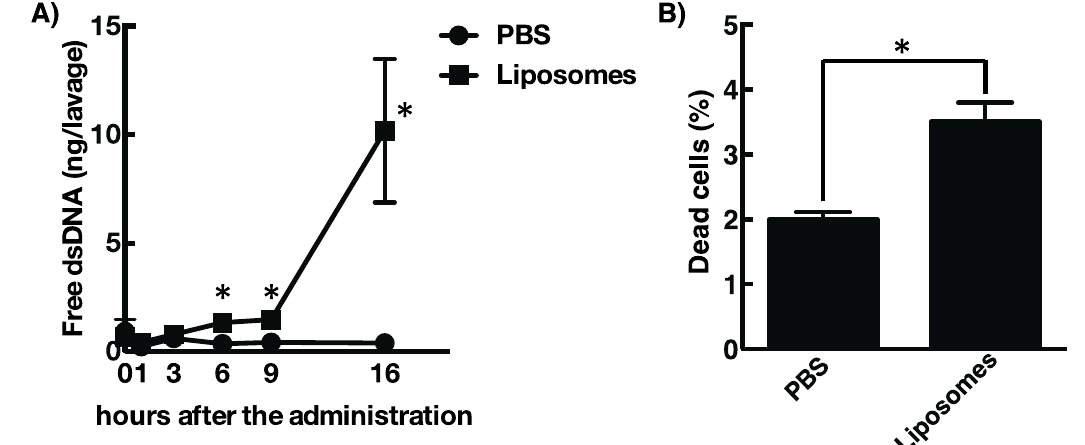
Figure 3. Cationic liposomes induce cell death at the site of administration resulting in the release of host dsDNA. ( A ) The amount of free dsDNA in nasal washes collected from mice i.n. administration with DOTAP / DC-chol liposomes estimated by a fluorescent based method using a Hoechst 33258. ( B ) Rate of dying cells in the nasal mucosa of mice i.n. administration with DOTAP / DC-chol liposomes were assessed by staining with 7-amino-actinomycin D (7-AAD) followed by flow cytometric analysis. At least three independent experiments were conducted, and data are expressed as means ± standard errors. Significance was assessed with t -test with Welch correction. * p < 0.05.